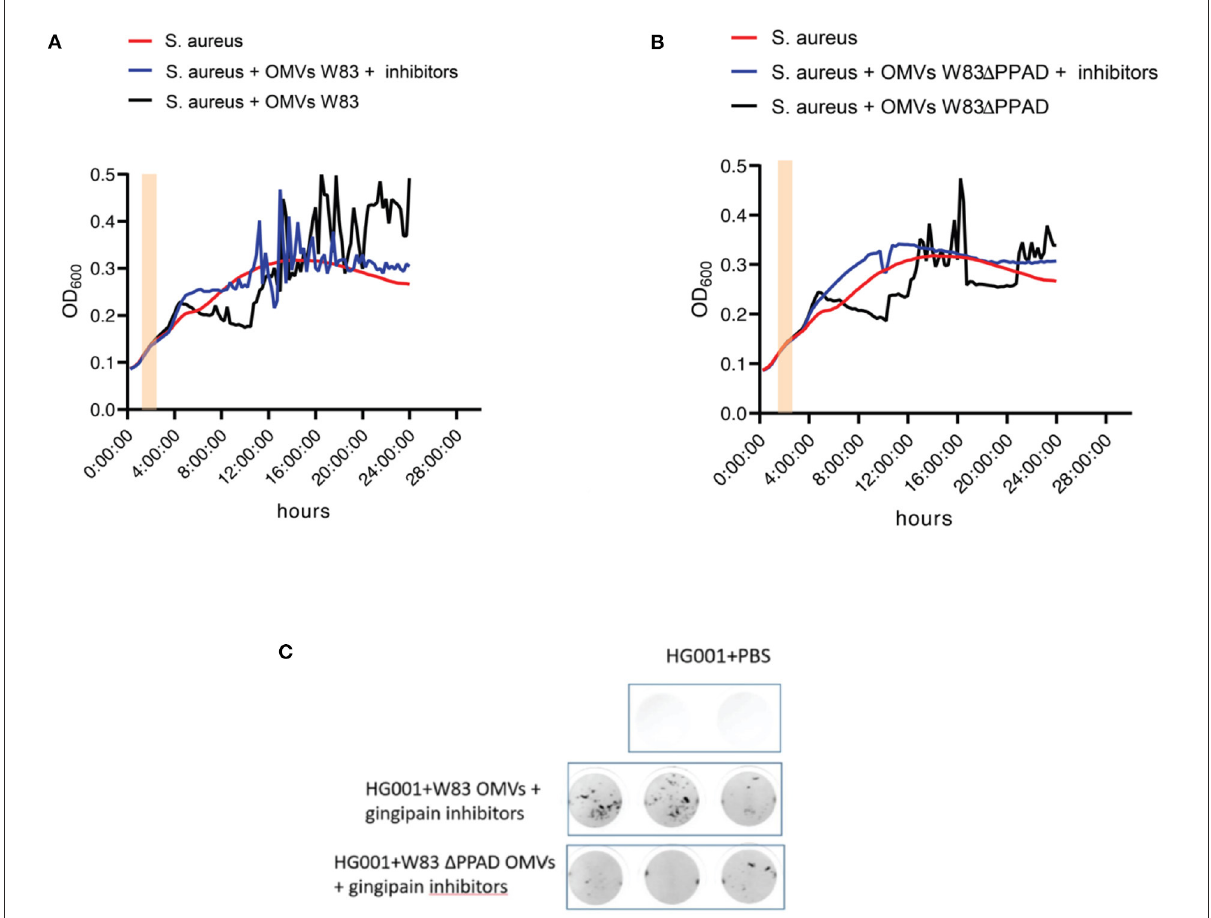
FIGURE3 OMV-mediated S. aureus aggregation is suppressed by the absence of PPAD and gingipain activity. (A) Growth curves of S. aureus HG001 with or without added OMVs of P. gingivalis W83 grown in the presence or absence of the gingipain inhibitors Cathepsin B inhibitor II and Leupeptin. (B) Growth curves of S. aureus HG001 with or without added OMVs of P. gingivalis W83 1 PPAD grown in the presence or absence of the gingipain inhibitors as in (A). (C) Scans of S. aureus aggregates in microtiter plate wells upon OMV exposure in the presence of gingipain inhibitors. Pink bars in the growth curves mark the addition of OMVs to the cultures. Each condition involved four biological replicates and one technical